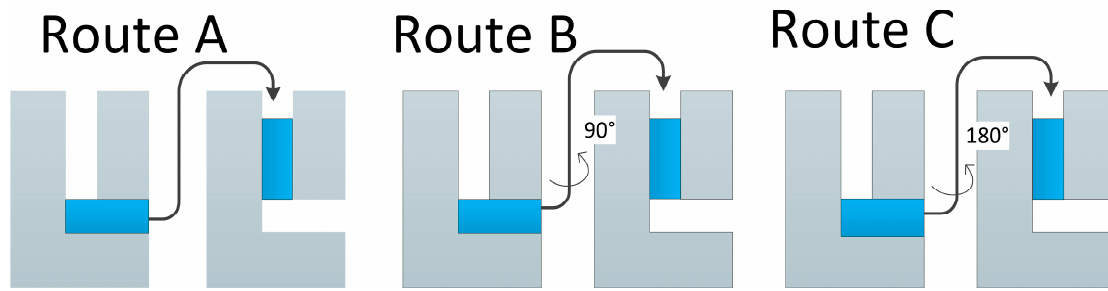
Figure 2. Characteristics of most important ECAP processing routes.